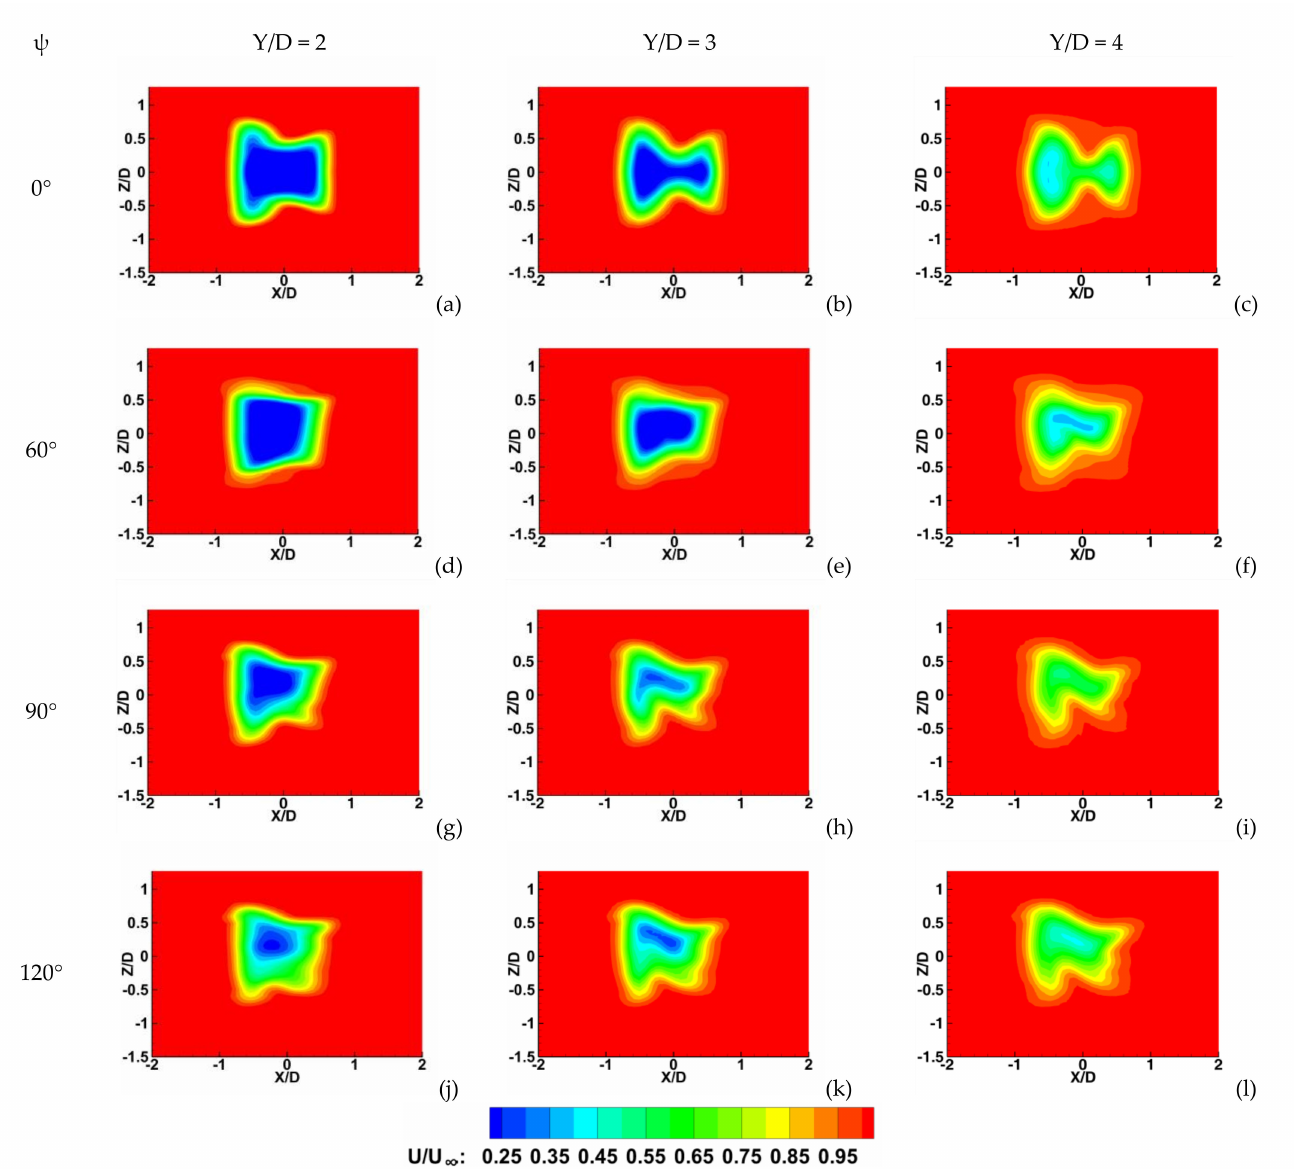
Figure 22. Wake structure of helical blade VAWT at Y/D of 2 ( a , d , g , j ), 3 ( b , e , h , k ), and 4 ( c , f , i , l ). For straight and helical- bladed VAWT at TSR =